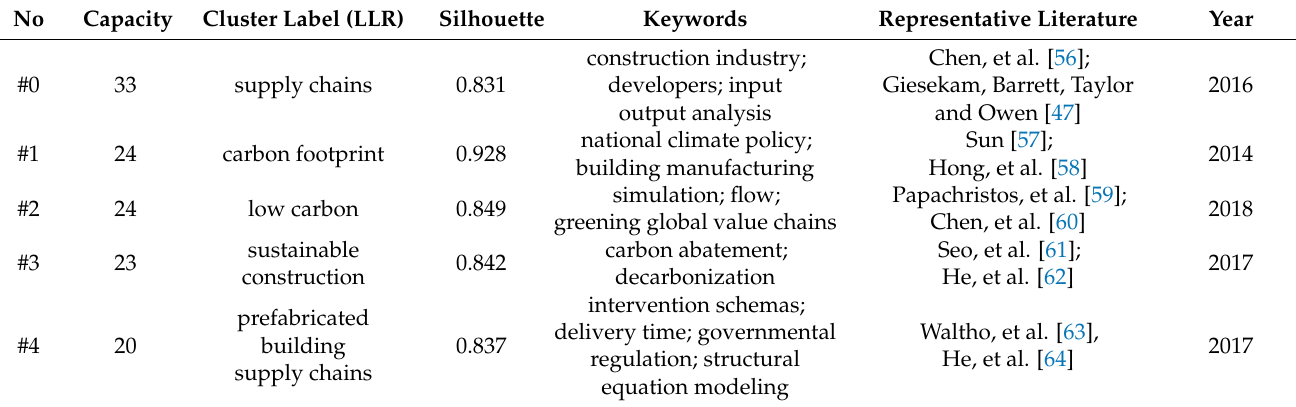
Table 7. Top-ranked clusters and the main keywords within the clusters.